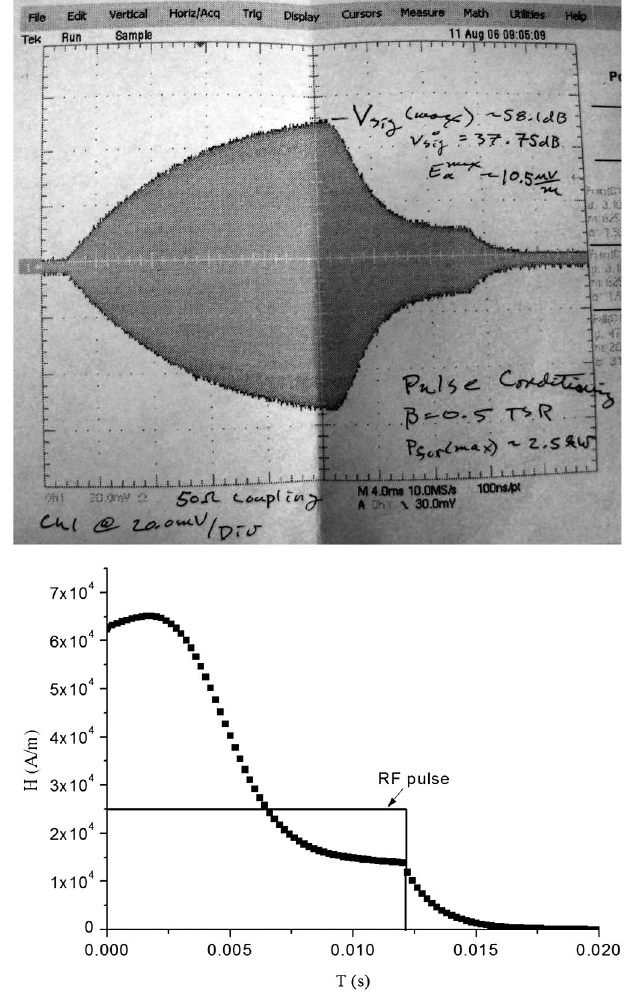
FIG. 10. Voltage evolution of real quench (top) and magnetic field evolution of simulation